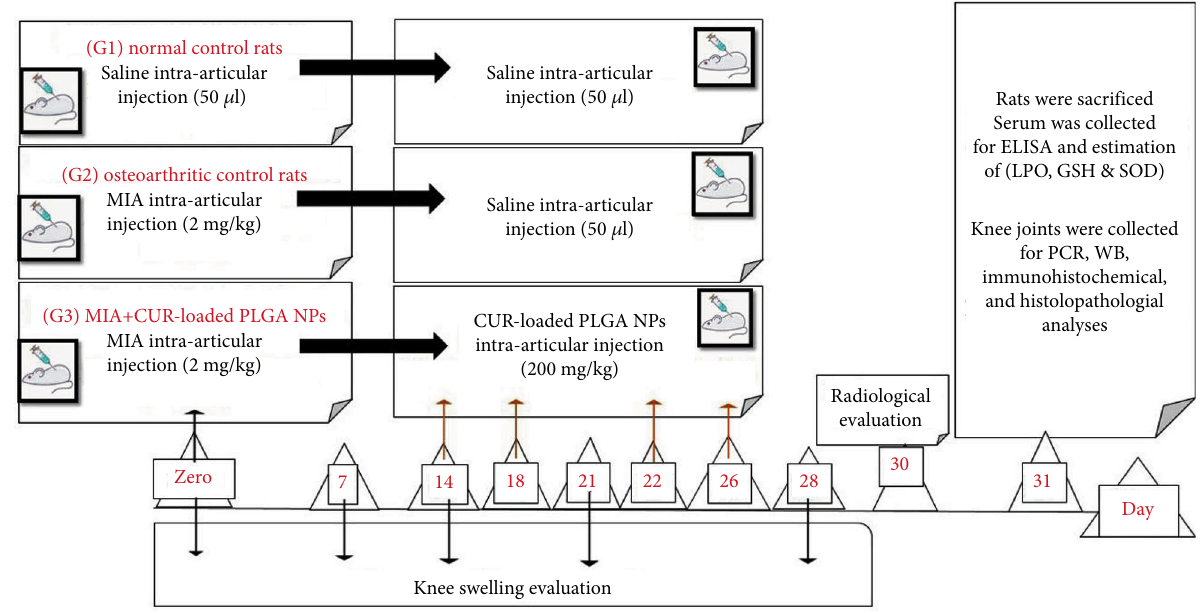
Figure 1: Timeline of the experiment showing the animal groupings, osteoarthritis (OA) induction on day 0, treatment on days 14, 18, 22, and 26, and animal euthanasia on day